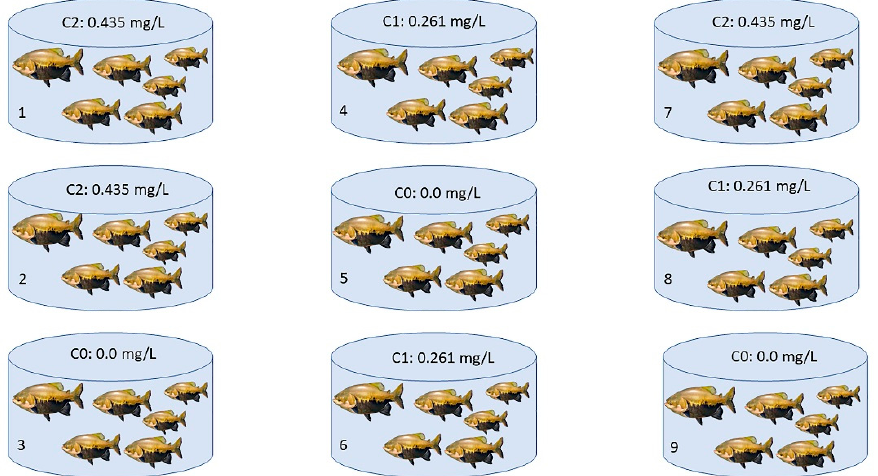
Figure 1. Experimental design using C. macropomum as a model organism. The tanks were randomly distributed: the tanks 5, 3, and 9 with C0 corresponding to 0.0 mg/L of Trichlorfon diluted in the water (three tanks with six specimens = 18 specimens analyzed); the tanks 4, 6, and 8 with C1 corresponding to 0.261 mg/L of Trichlorfon; and the tanks 1, 2, and 7 with C2 corresponding to 0.435 mg/L of Trichlorfon. Then 18 fish per treatment were analyzed, six per tank. N sampled—54